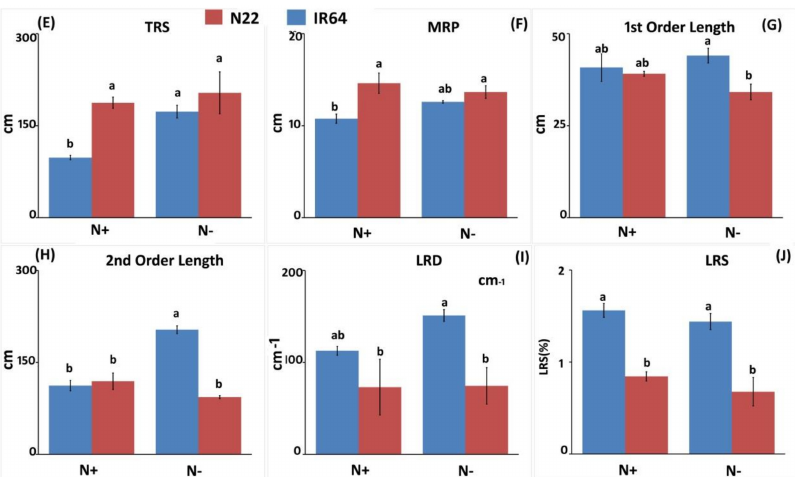
Figure 3. Root system architecture (RSA) parameters of the two rice genotypes, IR 64 and Nagina 22, under optimal (N+) and low N (N − ). ( A – D ) RSA images of IR64 and N22 under N+ and N − ; ( E ) Total root size; ( F ) Maximum root length; ( G ) First order root length; ( H ) Second order root length; ( I ) Lateral root density; ( J ) Lateral root